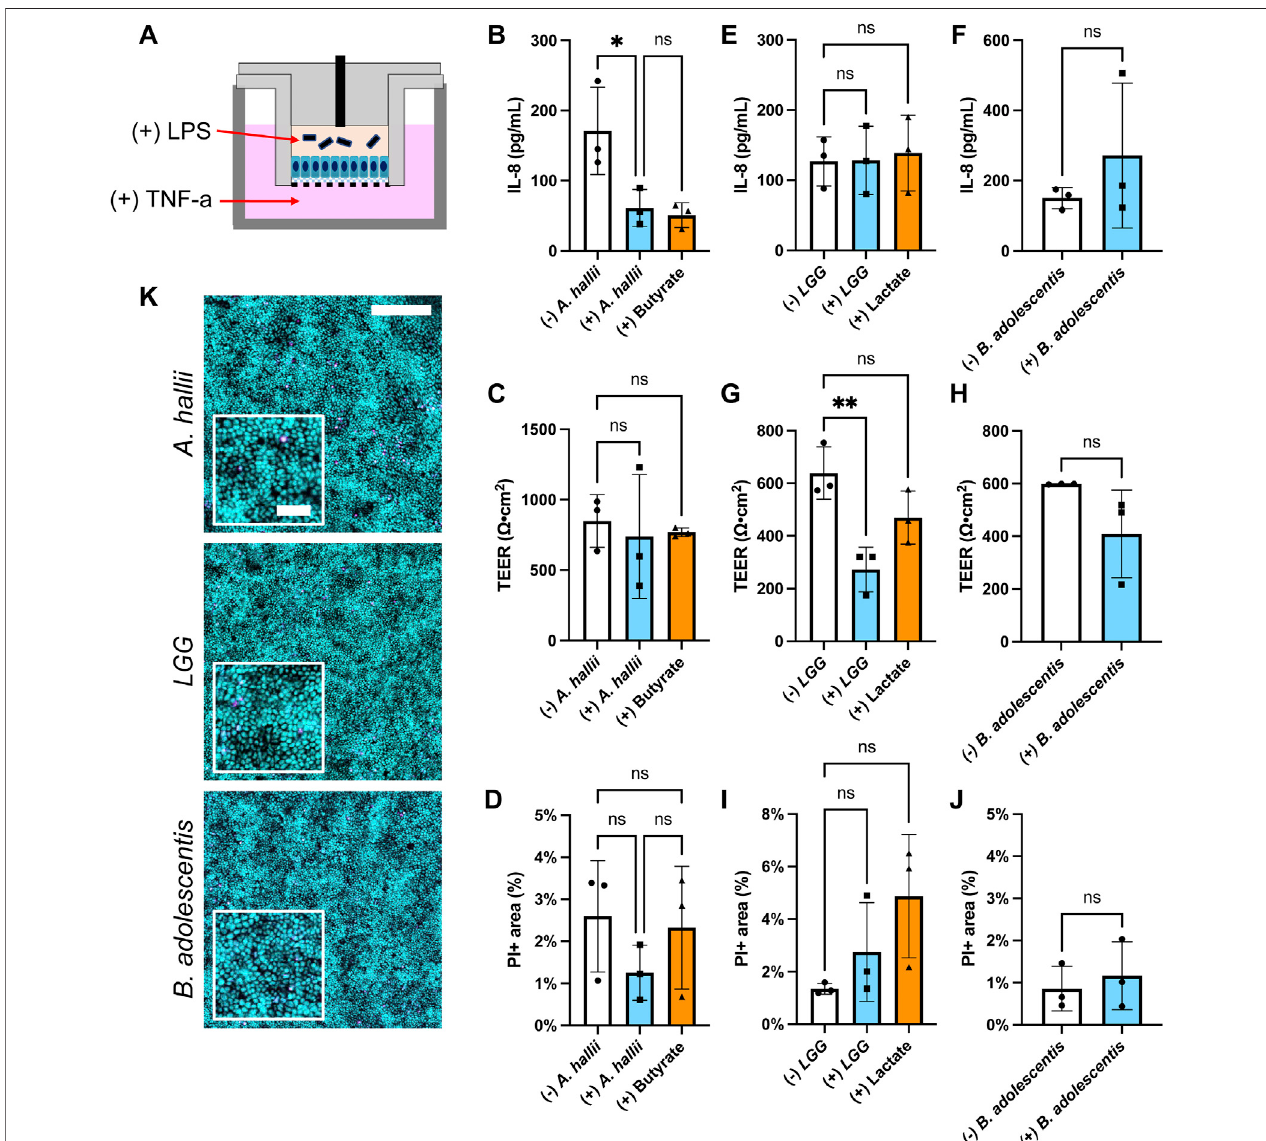
FIGURE3 | Impact ofbacteriaon IL-8 secretion by LPS/TNF- α treated intestinal epithelium. Donor 1tissue wasutilized for these experiments and 5× 10 4 CFU/ml of bacteria was inoculated onto each epithelial cell sample. (A) Schematic of the co-culture experiments with in fl ammatory stimulants (B,C,E – H) IL-8 concentration (B,E,F) and TEER (C,G,H) measured after24 hculturewithand without (B,C) A.hallii , (E,G) LGG ,or (F,H) B.adolescentis .For(+)butyrate or(+)lactate samples,3 mM butyrate (B,C) and5 mMlactate (C,G) wereaddedtotheluminalmediawithoutadditionofbacteria.Thebarsrepresenttheaverageofthemeasurements,andthe errorbarsindicatethestandarddeviationofthedata. n =3technicalreplicatesforalldata.* p ≤ 0.05;** p < 0.01;ns.notsigni fi cantlydifferent (D,I,J) Epithelialcelldeathin the in fl amed epithelial cell model after coculture with bacteria. Shown on the y-axis is the area positive for PI fl uorescence divided by that positive for Hoechst 33342 fl uorescence- PI area (%). The human colonic epithelial cells from donor 1 were cocultured with (D) A. hallii , (I) LGG, or (J) B. adolescentis . ns indicates not signi fi cantly different. n = 3 technical replicates for all data, except (B) control without bacterial exposure ( n = 2). One-way ANOVA (B-D,E,G,I) and t -test (F,H,J) were used for the statistical analyses. (K) Fluorescence images of the human colon epithelial cells stained with Syto 9 (cyan) and propidium iodide (magenta) after co-culture with A. hallii , LGG , and B. adolescentis for 24 h. Scale bar = 200 μ m in the larger image and 50 μ m in the inset.